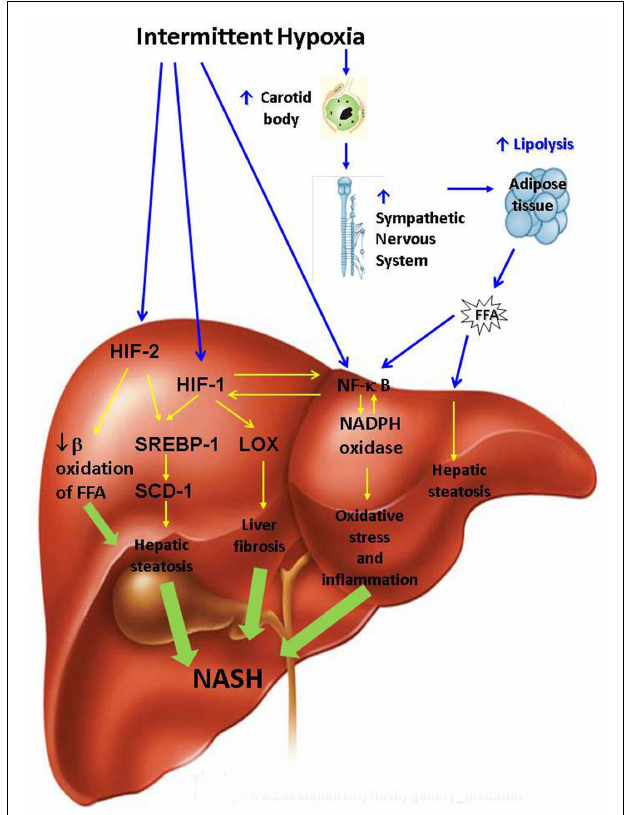
FIGURE 2 | Putative pathways leading to non-alcoholic steatohepatitis (NASH) during intermittent hypoxia of obstructive sleep apnea. FFA, free fatty acids; HIF, hypoxia inducible factor; LOX, lysyl oxidase; NADPH, nicotinamide adenine dinucleotide phosphate (NADPH); NF- κ B, nuclear factor kappa B; SCD, stearoyl coenzyme A desaturase; SREBP, sterol regulatory element binding